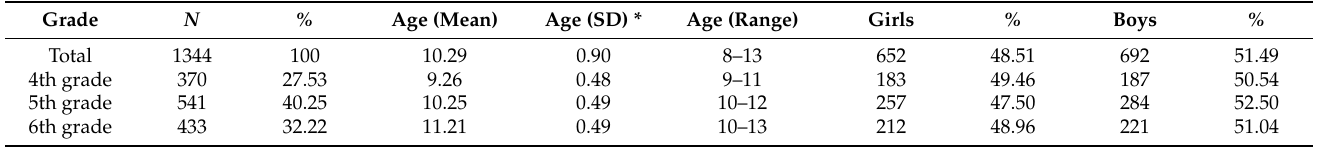
Table 1. Sample size and demographic characteristics of the participants split by